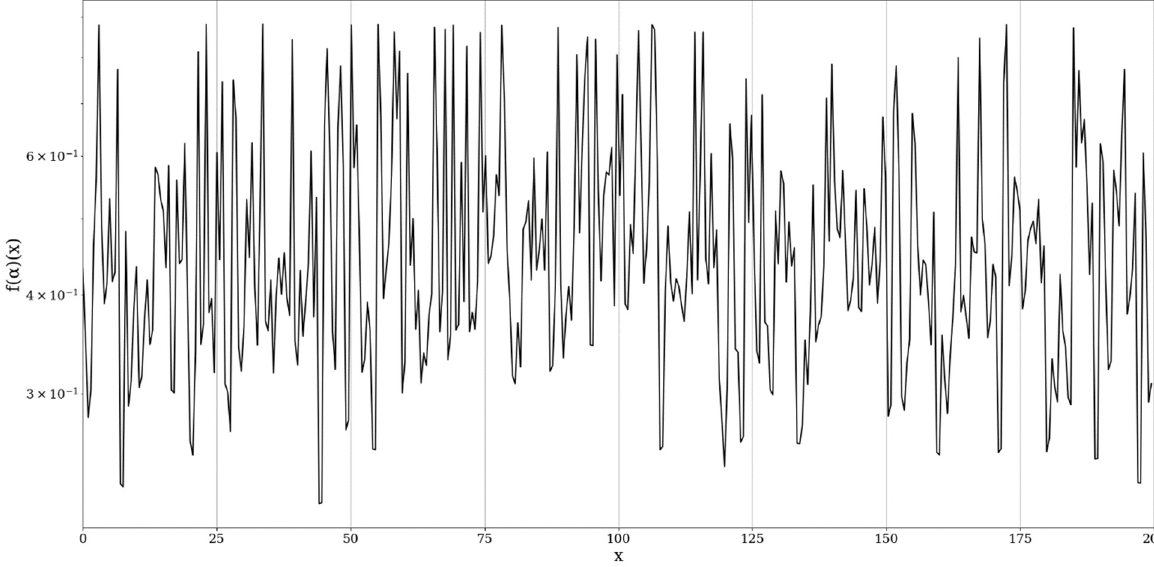
Figure 5. Singularity spectrum f(α)(x) plot in multifractal non-dimensional coordinates, Ω = 0.5 .